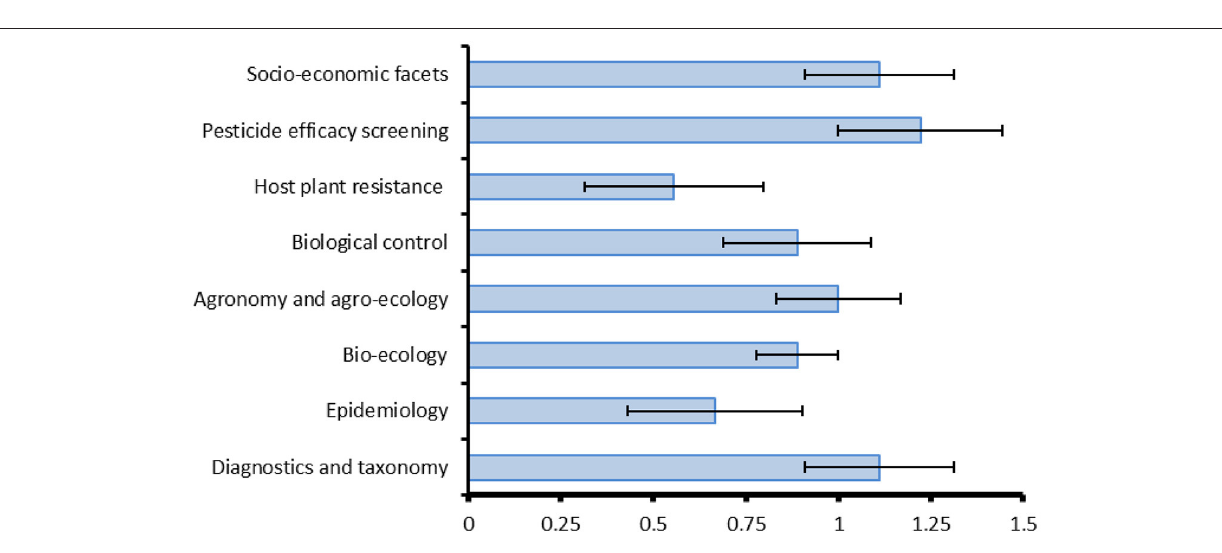
FIGURE 4 | Domestic scientific capability in different plant protection domains, as self-assessed by respondents from nine Asia–Pacific countries. For each of eight key domains, average patterns (x ± SE) are plotted and reflect overall in-country capacity on a scale from 0 to 2 (with 2 being “robust